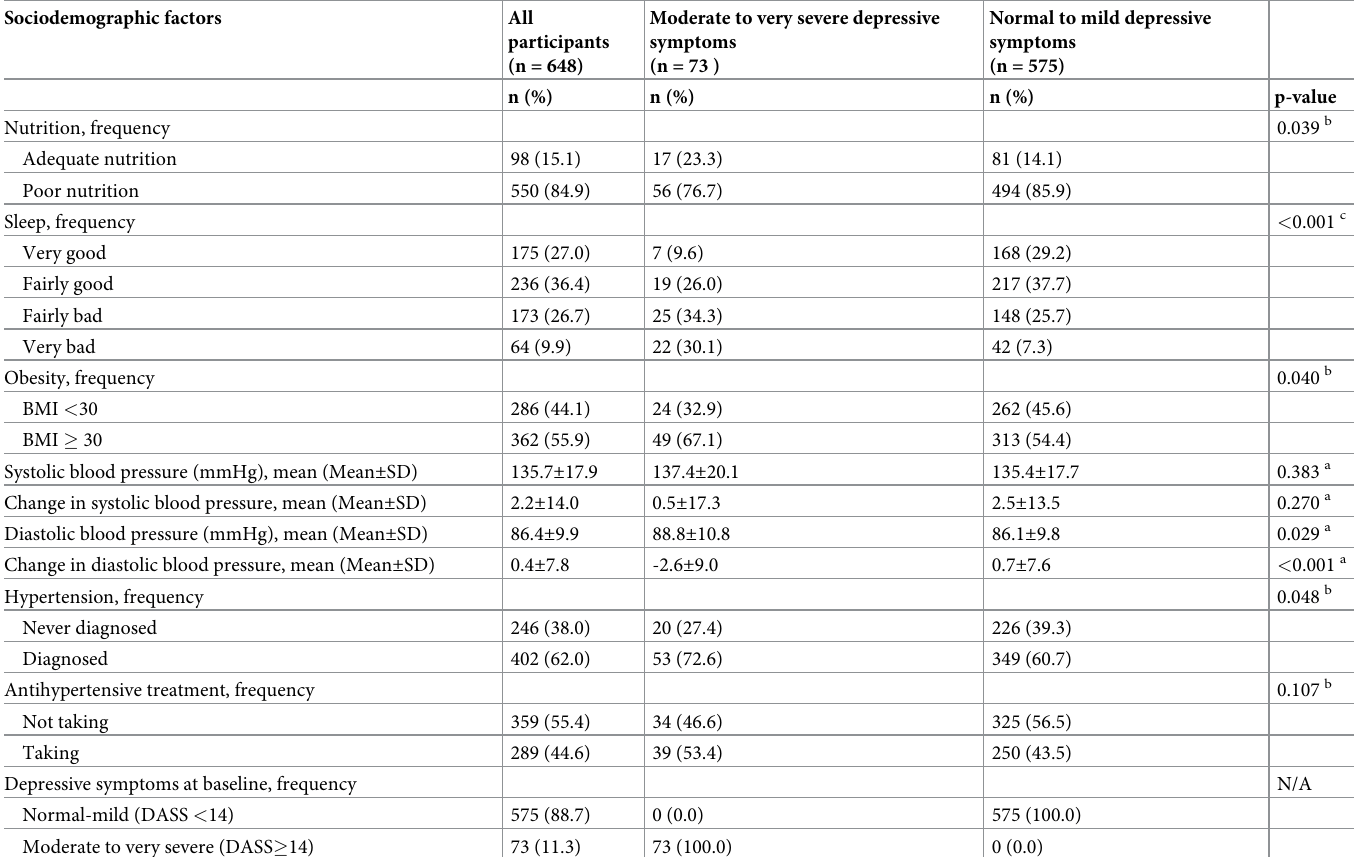
2.5.1 Change in systolic and diastolic blood pressure. Because clinically significant increases in blood pressure may fall short of specified cut-off criteria for hypertension, we cal- culated changes in blood pressure and used the change scores as a continuous outcome vari- able for systolic and diastolic blood pressure. Systolic and diastolic blood pressure (in mmHg) was measured three times, at least three minutes apart, after sitting quietly for about 10 minutes, using an M3 model Omron blood pressure monitor (Omron Healthcare, Switzerland). The research nurses placed the blood pressure cuff two centimetres above the elbow on the bare left upper arm (in the case of arte- riovenous fistula, radiotherapy or removal of lymph nodes in the armpit of the left arm, the right arm was used) of the seated participant and elevated the arm on the table to the level of the fourth intercostal space. Participants provided additional written consent that they would like to be informed by the study nurse in case high blood pressure was detected throughout the